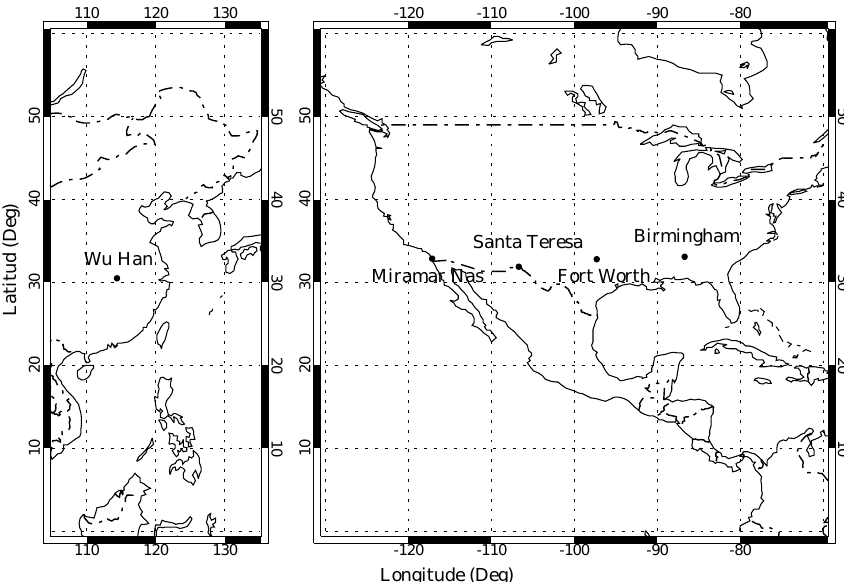
Fig. 1. Geographic locations of the five chosen radiosonde